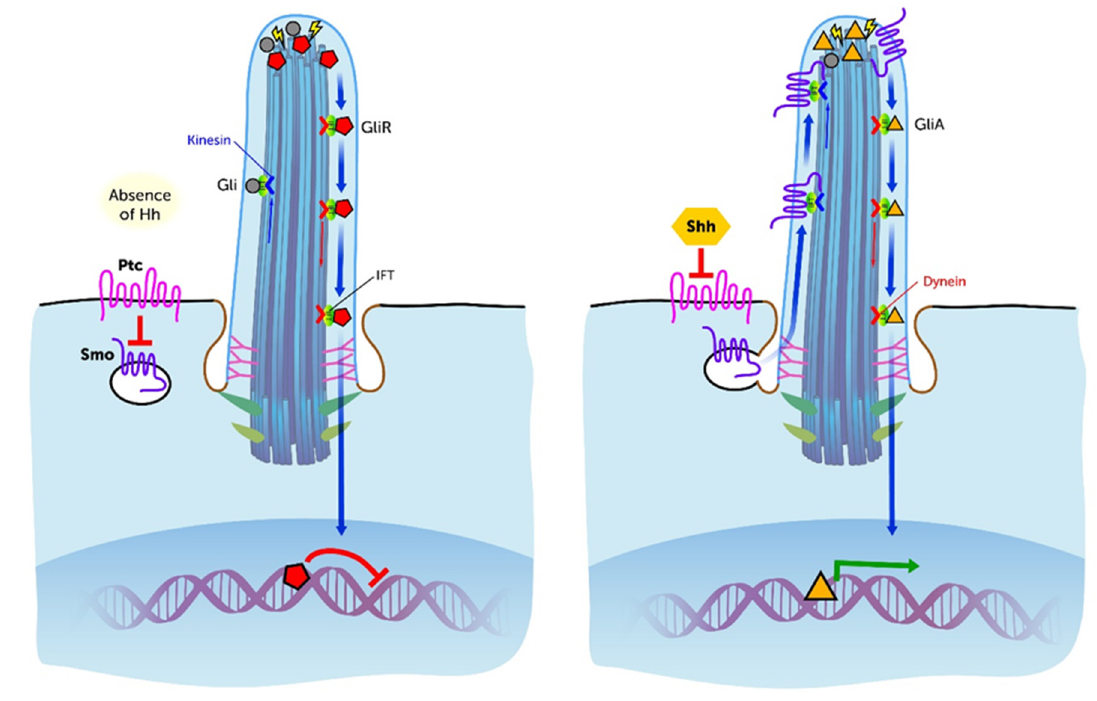
Figure 4. The physiological structure and functioning of the Primary Cilium are prerequisites for proper Shh pathway which is responsible for an adequate skeletal development, tissue patterning and thus an ordered cartilage and bone growth. Particularly, the Intraflagellar Transport (IFT) associated proteins are of high importance in this respect. Without Shh signal gli proteins (grey circles) are activated (yellow flashes) to their repressor form (red pentagons) by the inhibition of Smo (purple wavy line) via the Ptc receptor (pink wavy line). In the presence of Shh (yellow hexagon) Ptc is blocked and Smo is released to the cilium, where gli proteins are activated to their transcriptional activator forms (orange triangles). The anterograde and retrograde transport function along the Axoneme via IFT motor proteins (Kinesin and Dynein) enables the translocation of the Gli transcription factors to the nucleus. Thus, the transcription of important genes during skeletal development is regulated. Disorders within this complex cascade lead to skeletal abnormalities. Image modified from Singla & Reiter (2006)